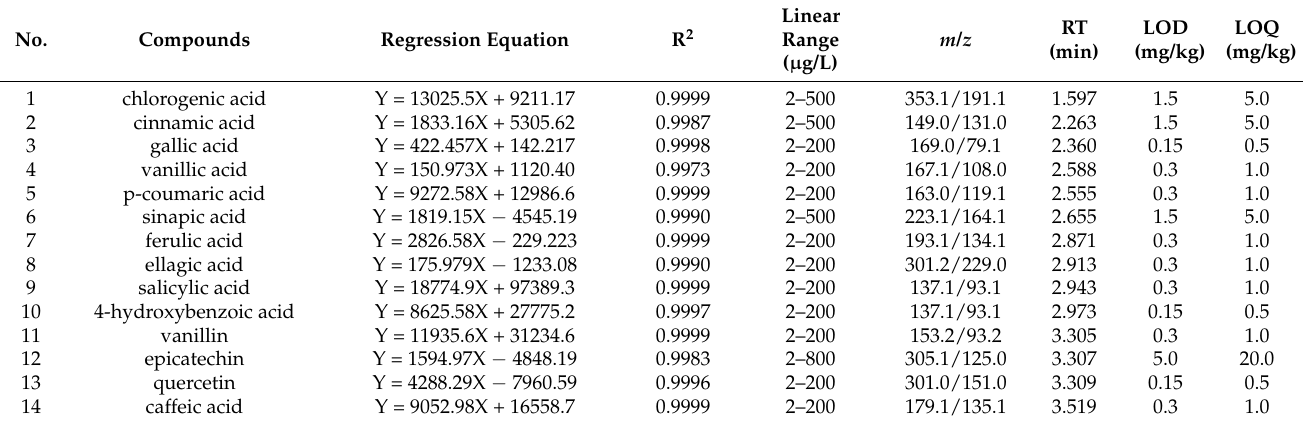
Table 1. The quantification information of phenolics in E. mollis